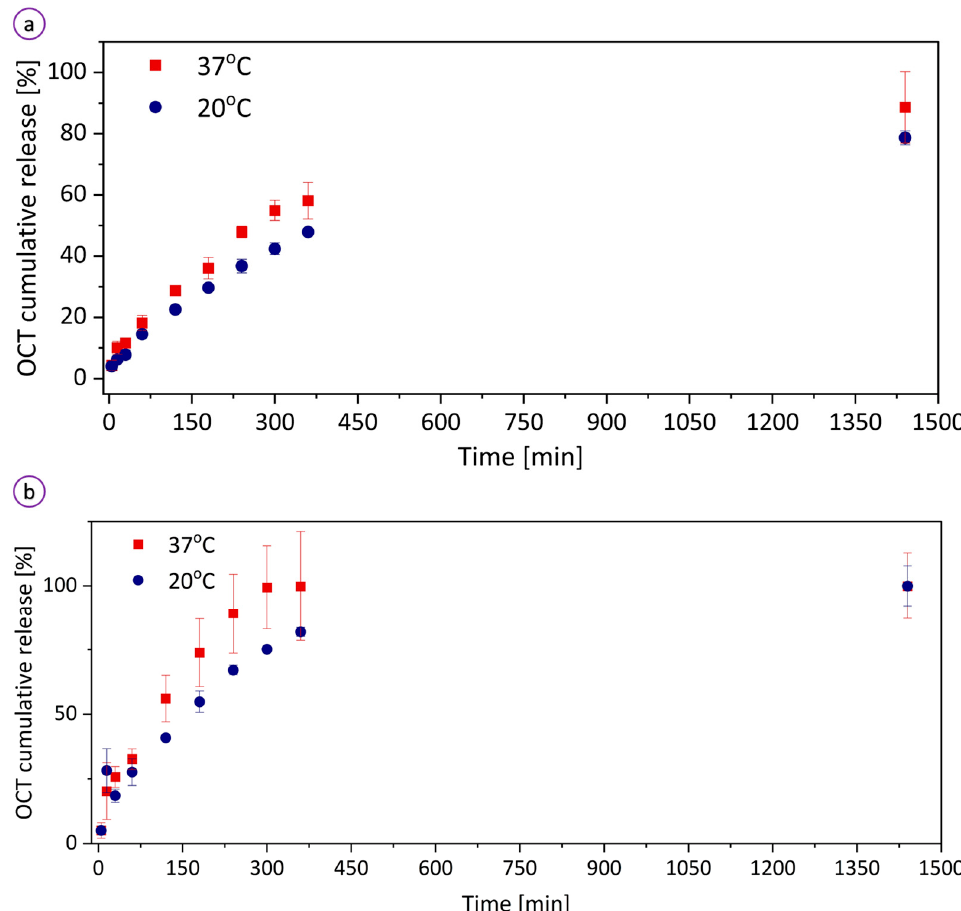
Figure 5. OCT release profiles from the hydrogel to ( a ) water and ( b ) PBS (pH of 7.4) at temperatures of 20 and 37 °C. of 20 and 37 ◦